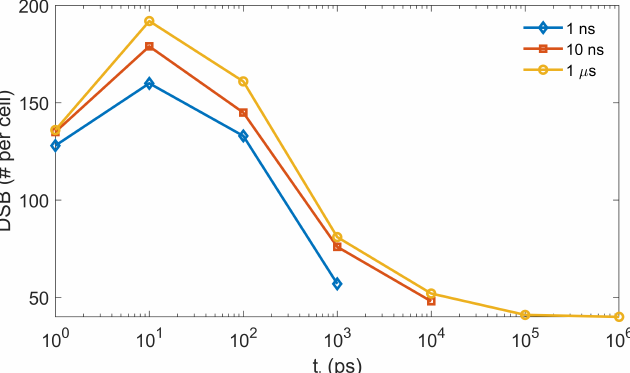
Figure 9. The yields of DSB at different t i and t c from the gMicroMC